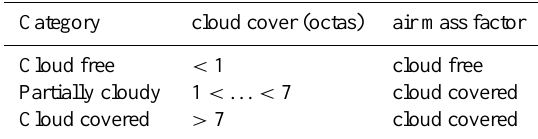
Table 1. Selection criteria for air mass factor calculations, based on the cloud